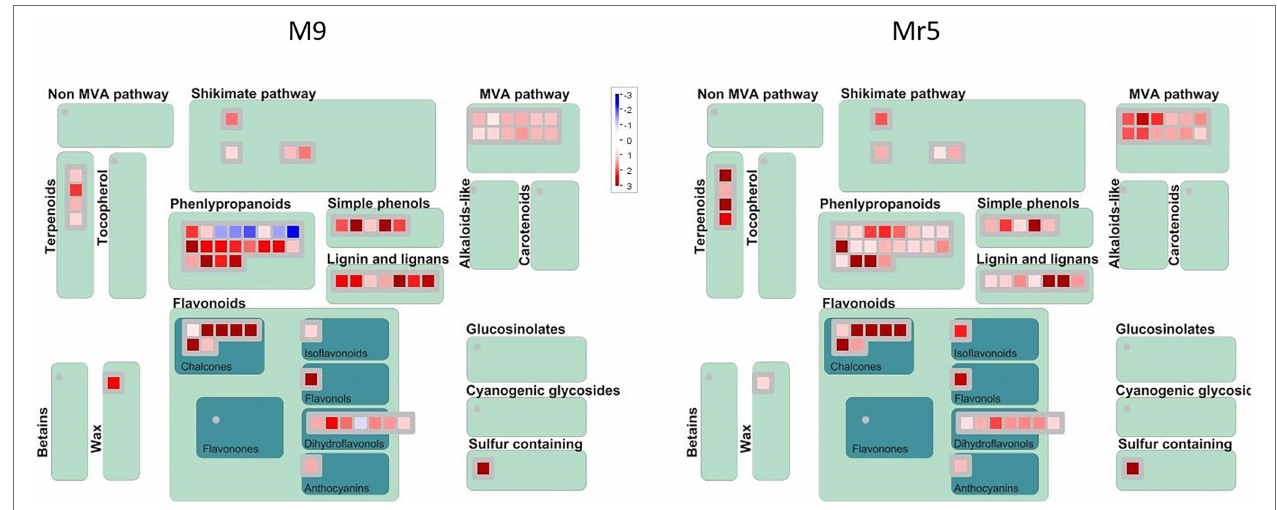
FIGURE 4 | MapMan secondary metabolism overview of genes differentially expressed in ‘M9’ and M. × robusta 5 (Mr5). The genes were assigned to 13 categories based on their expression pattern. A log 2 FC > 1 with a significance level of p < 0.05 indicates an upregulation (red), a log 2 FC < 1 with a significance level of p < 0.05 indicates a downregulation (blue). The intensity of the color represents the level of gene expression in the ARD soil relative to the γ ARD